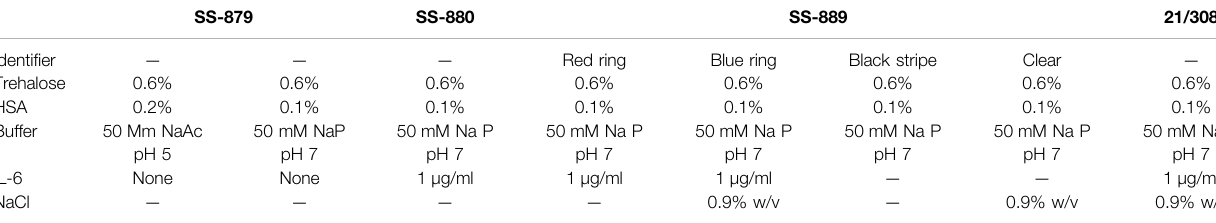
TABLE 1 | Descriptors of formulation options SS-879, SS-880, SS-889, and 21/308. SS-879